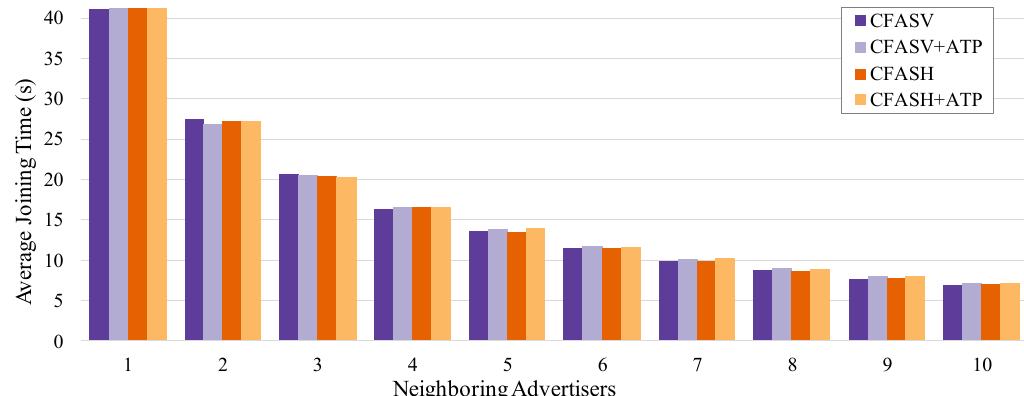
Figure 11. Comparison between CFASV and CFASH, with or without the use of ATP, in the case of a fixed joining node.